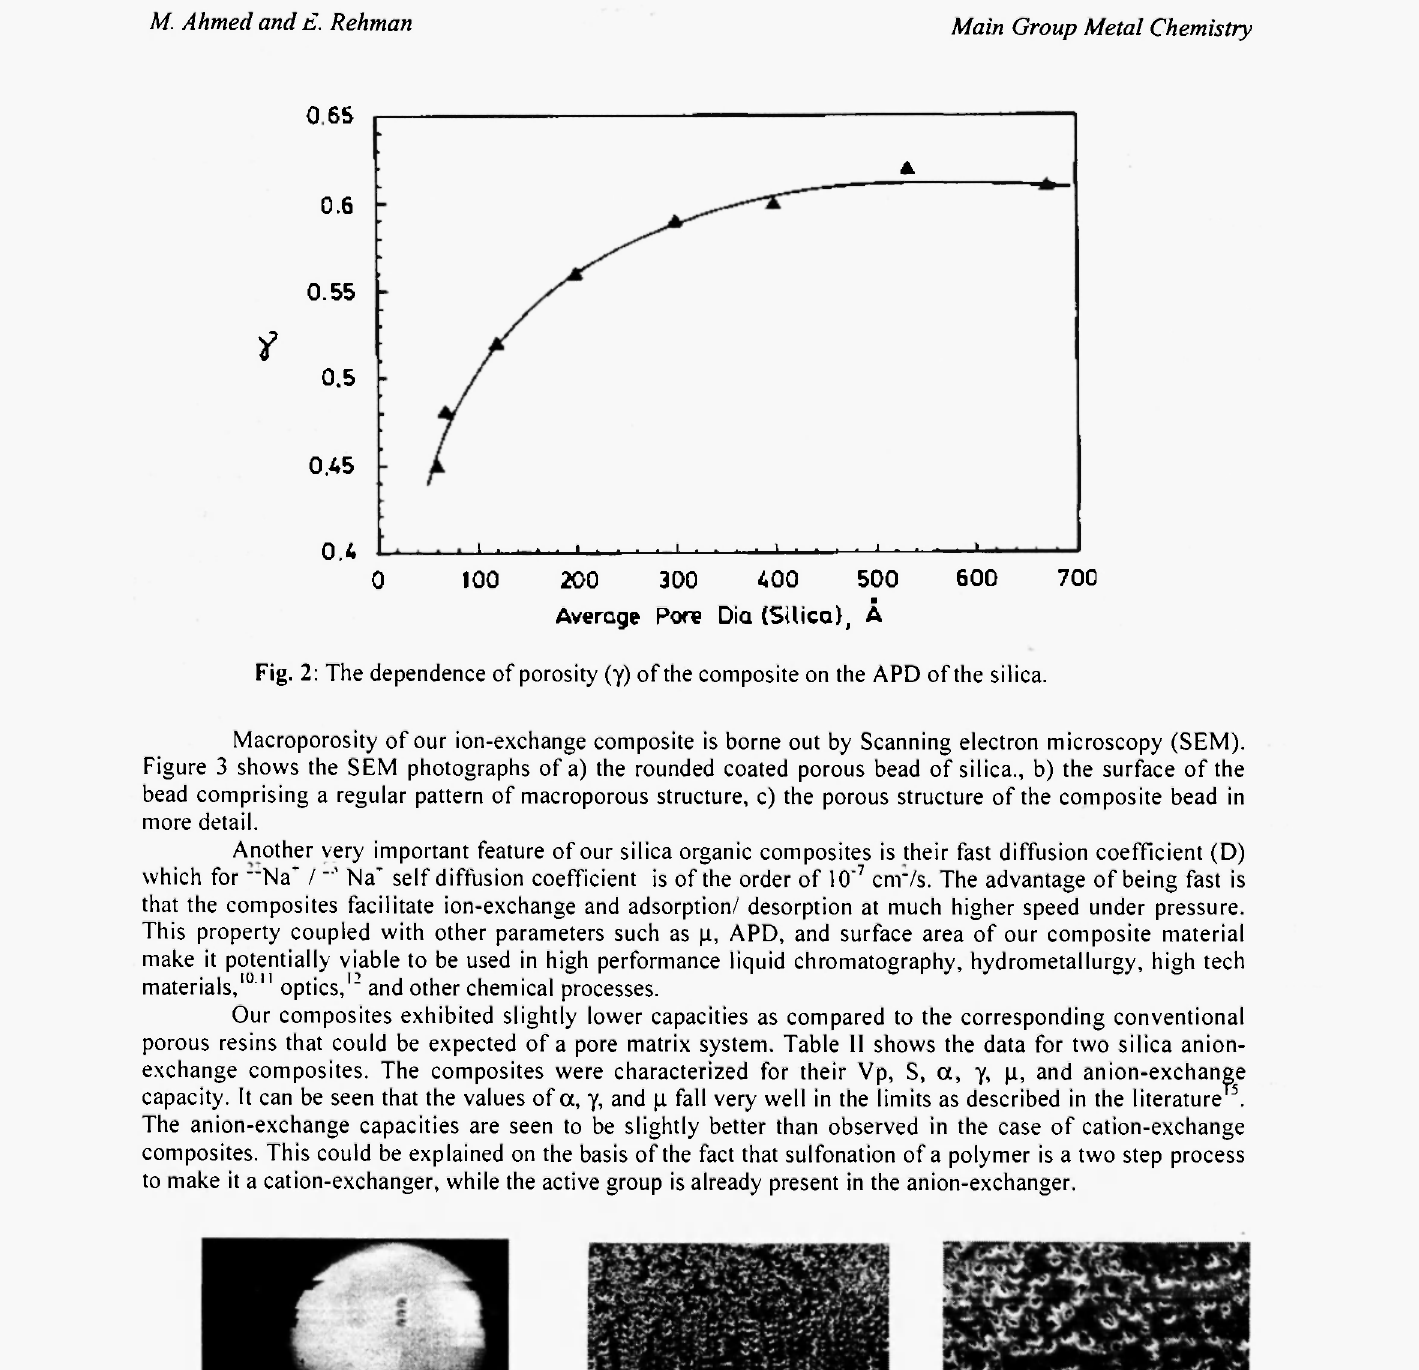
Fig. 3c:Surface of the porous composite bead, a closer view.